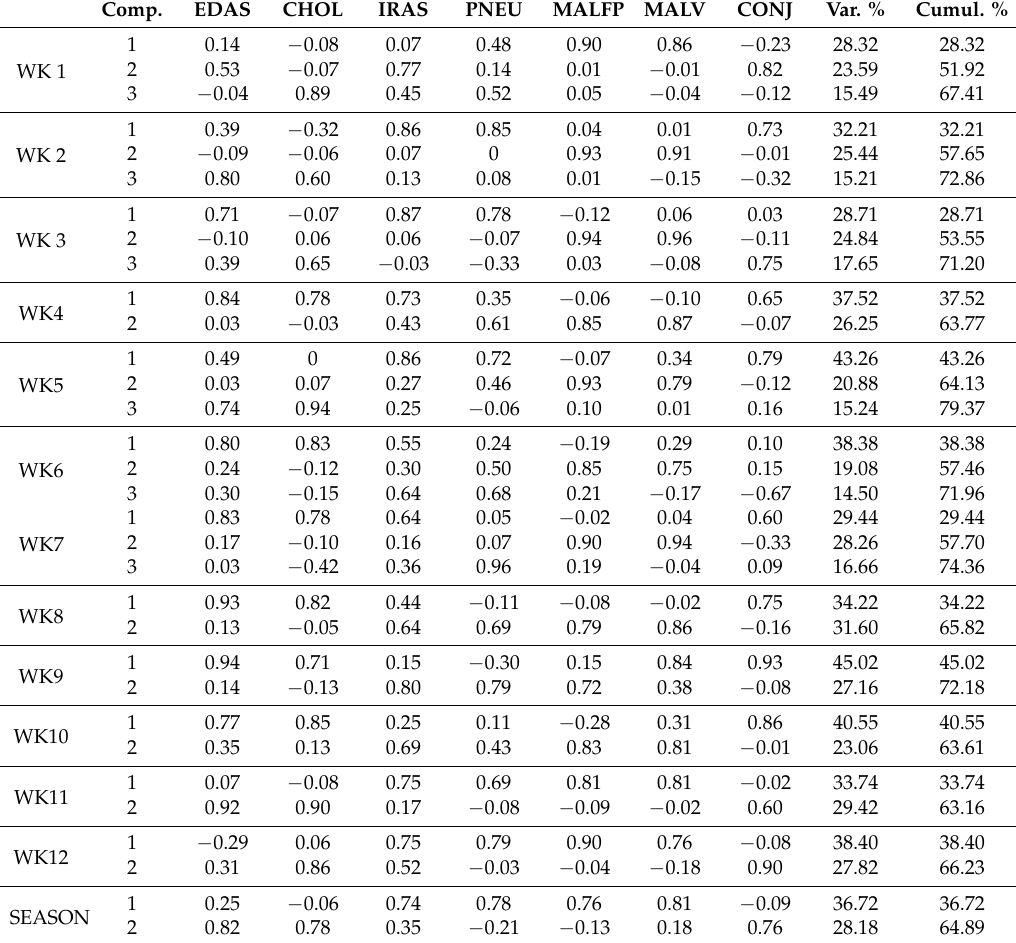
Table A4. Principal component analysis output for ecosyndemic indices by week and season.